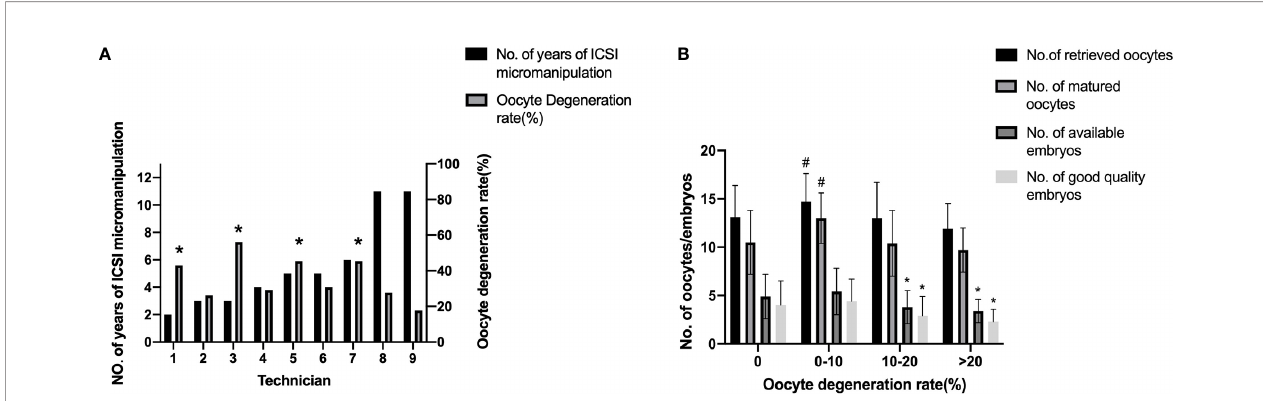
FIGURE 2 | Oocyte degeneration rates among ICSI technicians and fresh cycle outcomes according to different oocyte degeneration rates. (A) Oocyte degeneration rates among ICSI technicians. * P< 0.05 compared with the 9 th technician. (B) Fresh cycle outcomes according to different oocyte degeneration rates.*: P< 0.05 compared with the other two groups, # P< 0.05 compared with the other three groups. P <0.05 for the Bonferroni-adjusted following pairwise comparisons.